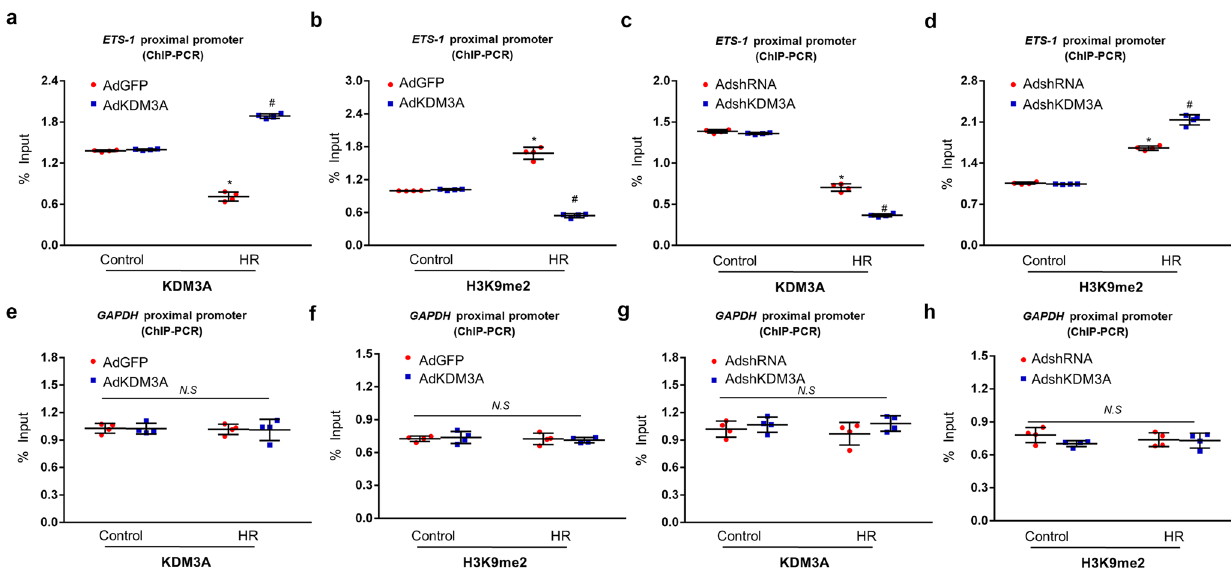
Fig. 8 ChIP-PCR assay demonstrated that KDM3A regulates the expression of ETS1 by modulating levels of H3K9me2 in its promoter region in the setting of H/R injury. a , b Primary NRCMs were transfected with AdKDM3A or AdGFP followed by H/R or control. ChIP followed by quantitative PCR (qPCR) with KDM3A and H3K9me2 antibodies. Data are expressed as the fold change compared to the corresponding control group ( n = 4, * P < 0.05 vs. AdGFP/Control; # P < 0.05 vs. AdGFP/H/R). c , d NRCMs were infected with AdshKDM3A or AdshRNA with or without H/R. ChIP followed by quantitative PCR (qPCR) with KDM3A and H3K9me2 antibodies. Data are expressed as the fold change relative to the corresponding control group ( n = 4, * P < 0.05 vs. AdshRNA/Control; # P < 0.05 vs. AdshRNA/H/R). e – h The enrichment of KDM3A and H3K9me2 on the GAPDH promoter were regarded as the control ( n = 4). Data are expressed as the fold change relative to the corresponding control group ( n = 4, NS : no signi fi cant